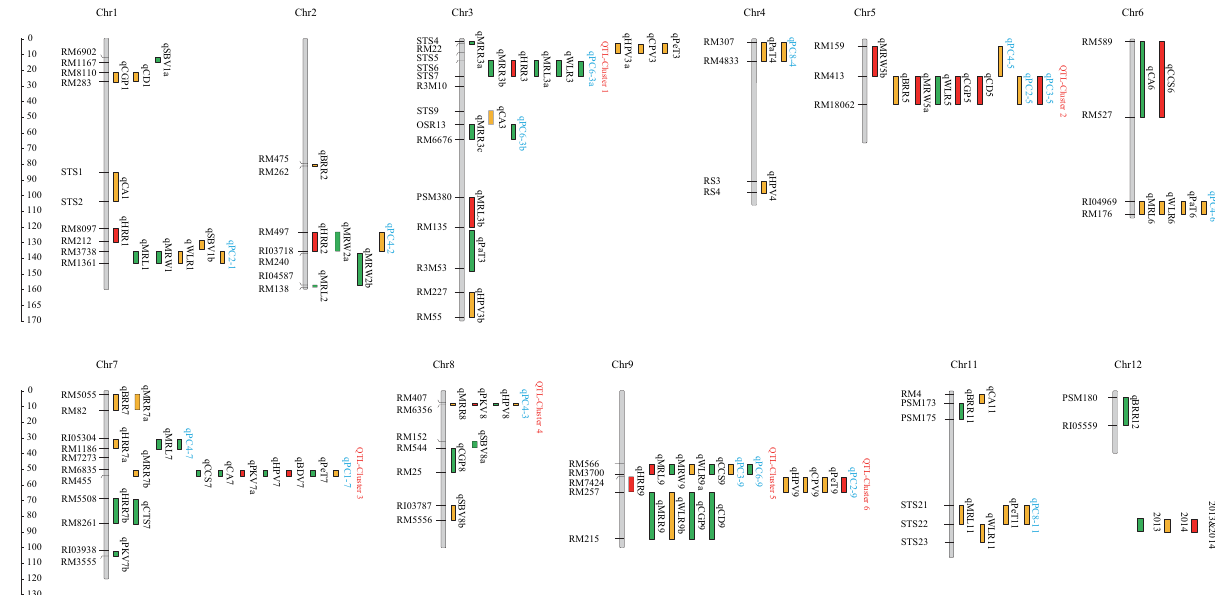
Figure 5. Location on the genetic map of QTL loci detected for quality traits. Green indicates QTL loci detected in 2013, yellow indicates QTL loci detected in 2014 and red indicates QTL loci detected in both